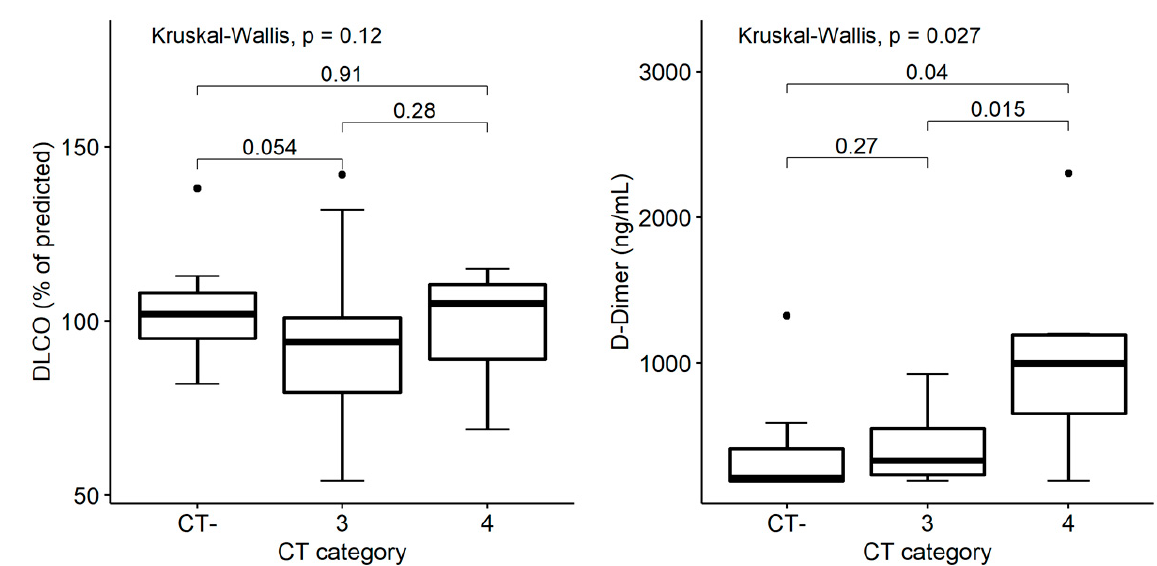
Figure 4. Association between radiological trend and clinical and laboratory findings 12 months after discharge among COVID-19 survivors, with normal ( CT- ), improved ( group 3 ) and stably abnormal ( group 4 ) chest CT findings. Box plots on the left show distribution of DLCO percentage of the predicted value by chest CT category. Box plots on the right show distribution of D-dimer values by chest CT category. p -values denote significance in overall and pairwise differences assessed by Kruskal–Wallis and Wilcoxon tests, respectively.